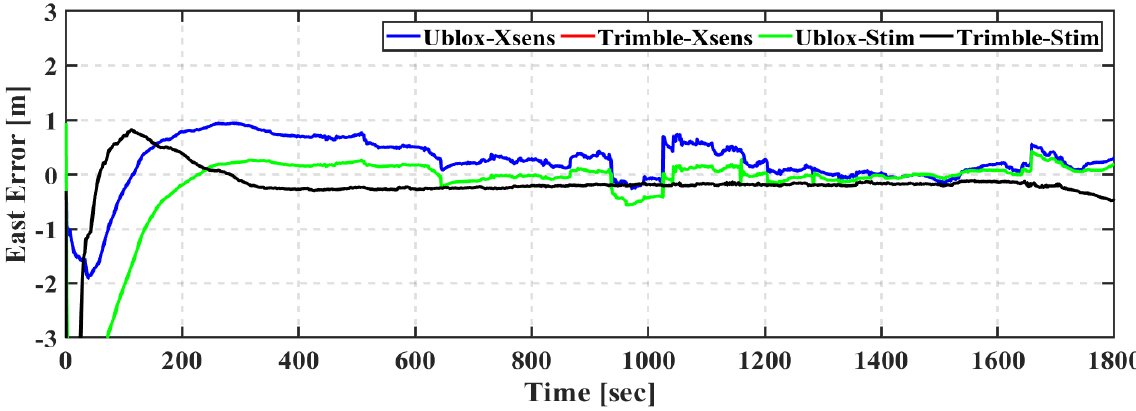
Figure 5. First field trial: East positioning error of real-time TC GNSS PPP/INS for Ublox–Xsens, Trimble–Xsens, Ublox–Stim, and Trimble–Stim solutions.